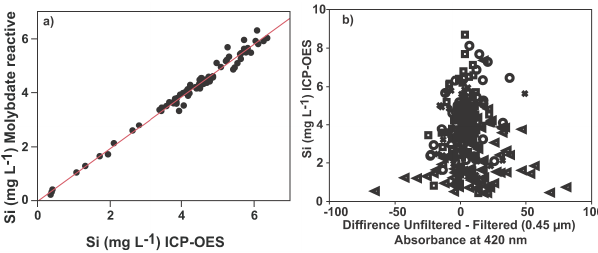
Fig. 6. (a) Concentration of molybdate reactive silica (mgL − 1 ) against total silica measured by ICP-OES measured at the moni- toring sites (Aneboda, G˚ardsj¨on and Kindla) that were within the samples catchments, and (b) comparison of absorbance at 420nm, unfiltered – filtered (0.45µm), against total silica (mgL − 1 ) ICP- OES in the presented data set. R. A. is represented by triangles,